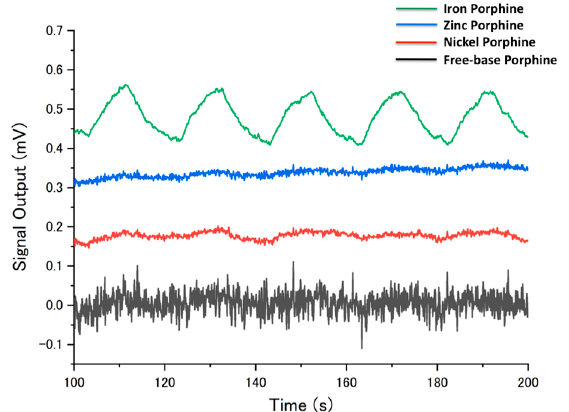
Figure 7. Sensing signals to 1-hexanol ( left ) and propionic acid ( right ) sensing at 25 °C, 10% in partial vapor concentration, 70% RH. The last five cycles of sample gas injection and nitrogen gas purge are shown. Sensors 2018 , 18 , x FOR PEER REVIEW